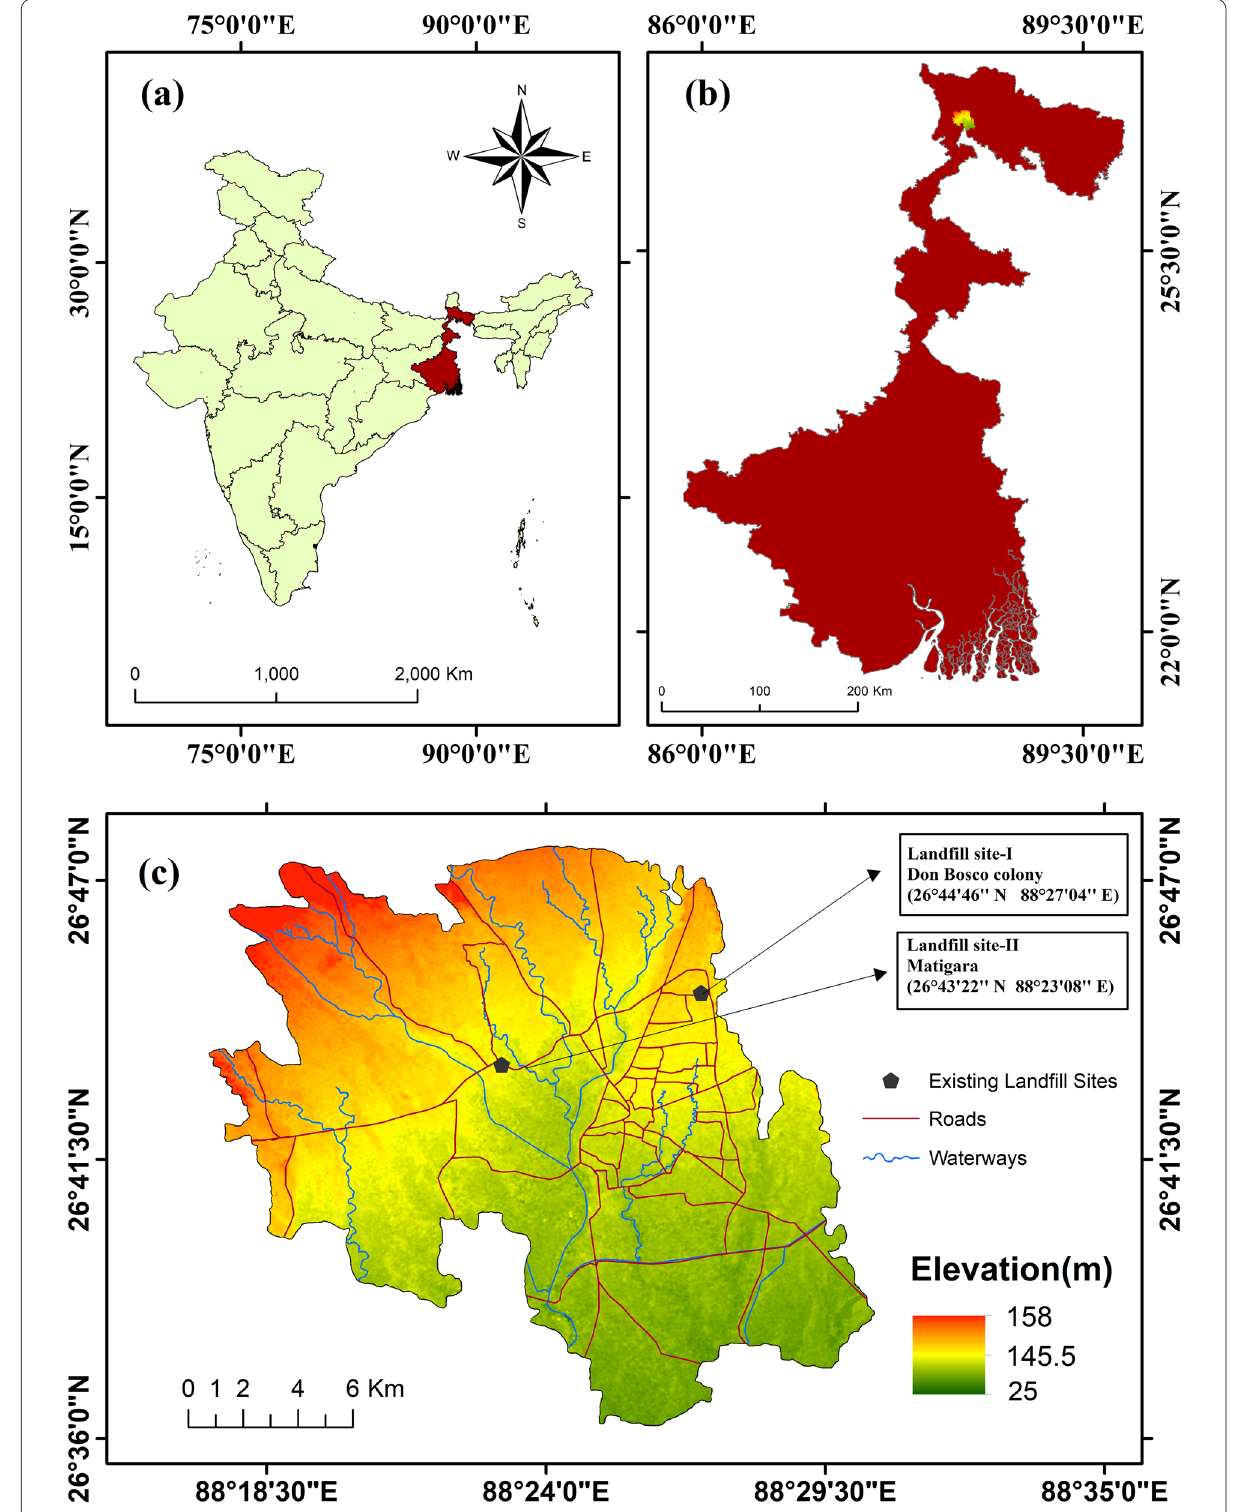
Fig. 3 Location of the study area a. India b. West Bengal c. Siliguri Municipal Corporation Planning Area (study area) with existing landfill